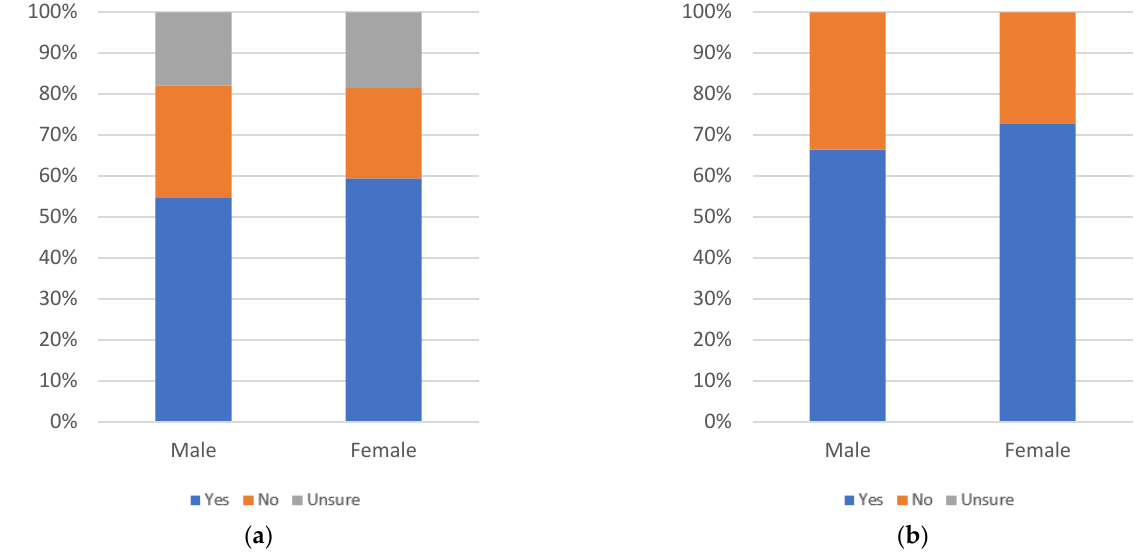
Figure 83. Label trustworthiness judging use, by gender: ( a ) with uncertain respondents (left) and ( b ) without uncertain respondents (right).